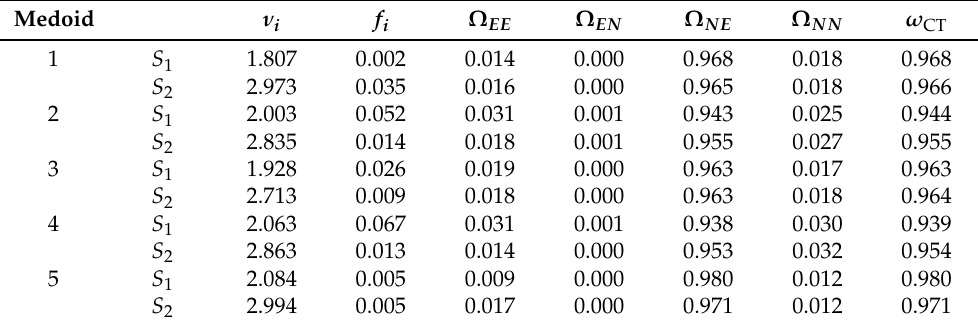
Table 2. Characterization of S 1 and S 2 excited states of TCNE: π :1ClN cluster medoids. ν i (eV):